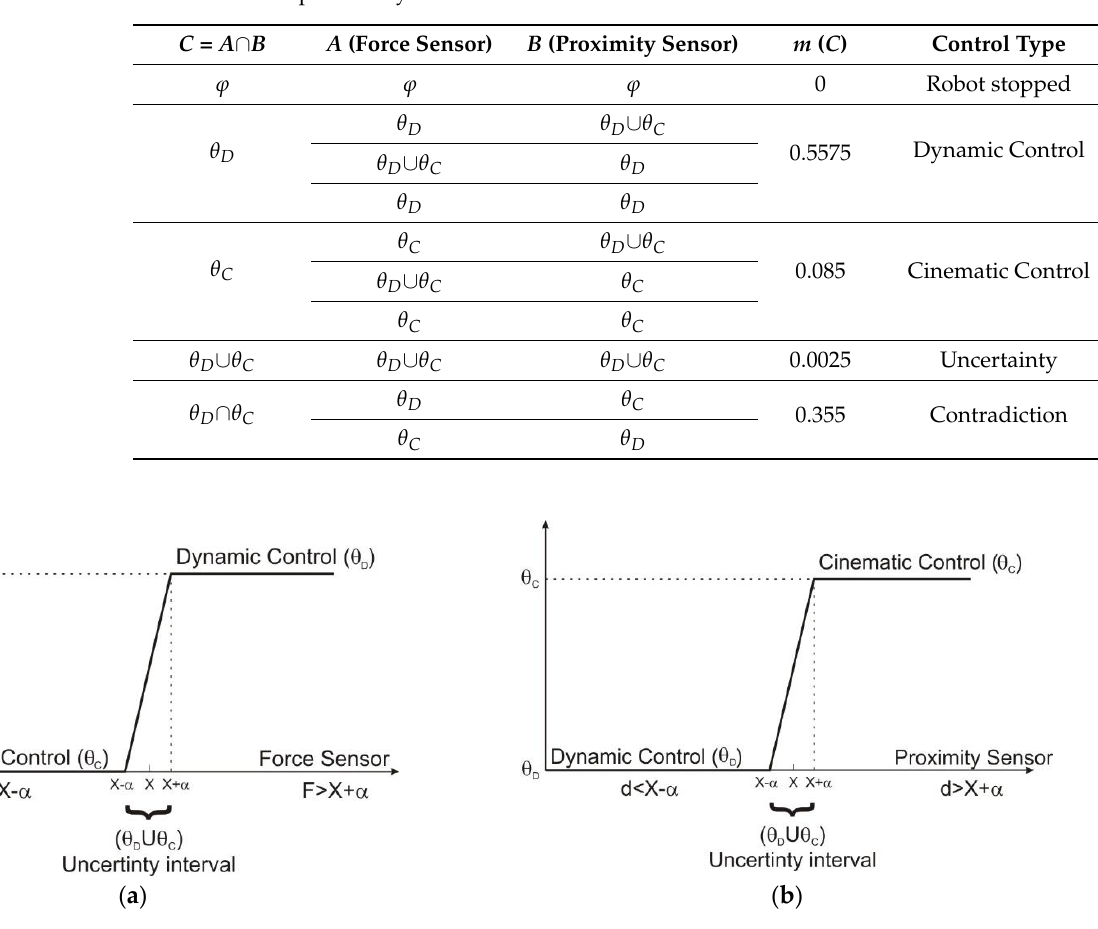
Figure 3. Control-deciding graphs: ( a ) force sensor graph; ( b ) proximity sensor graph.